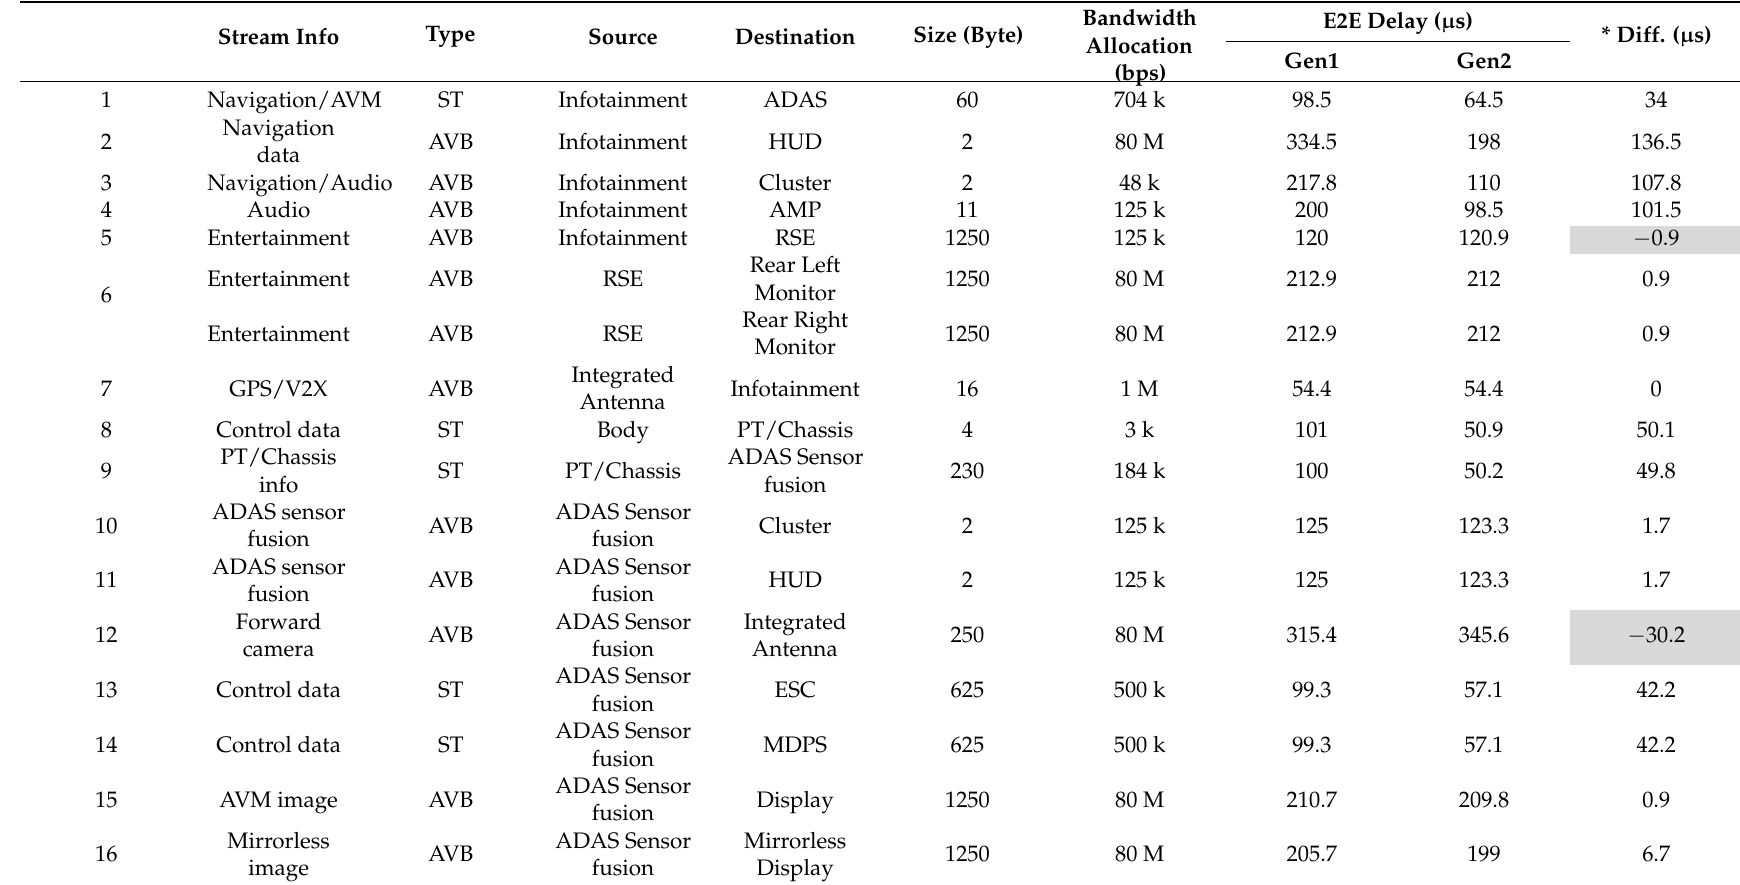
Table 5. TSN streams for autonomous